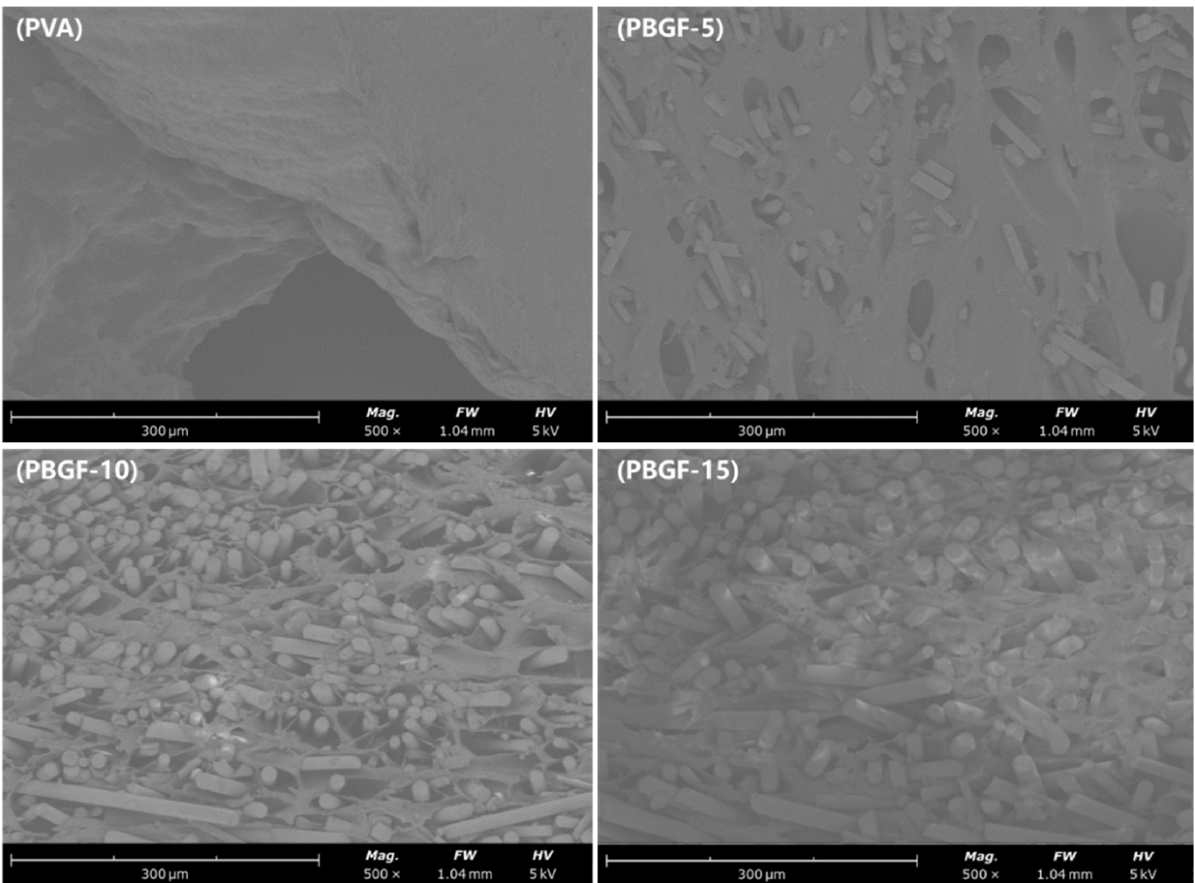
Figure 4. Scanning electron microscopic image of the pure PVA and PBGF composites.